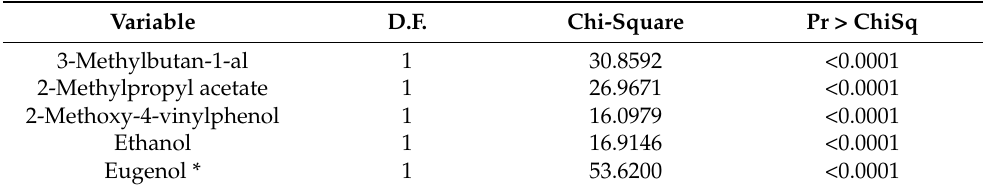
Table 2. Significant volatile substances distinguishing the different storage regimes of pear cultivars ‘Conference’ and ‘Yali’—selected by stepwise multinomial logistic regression.